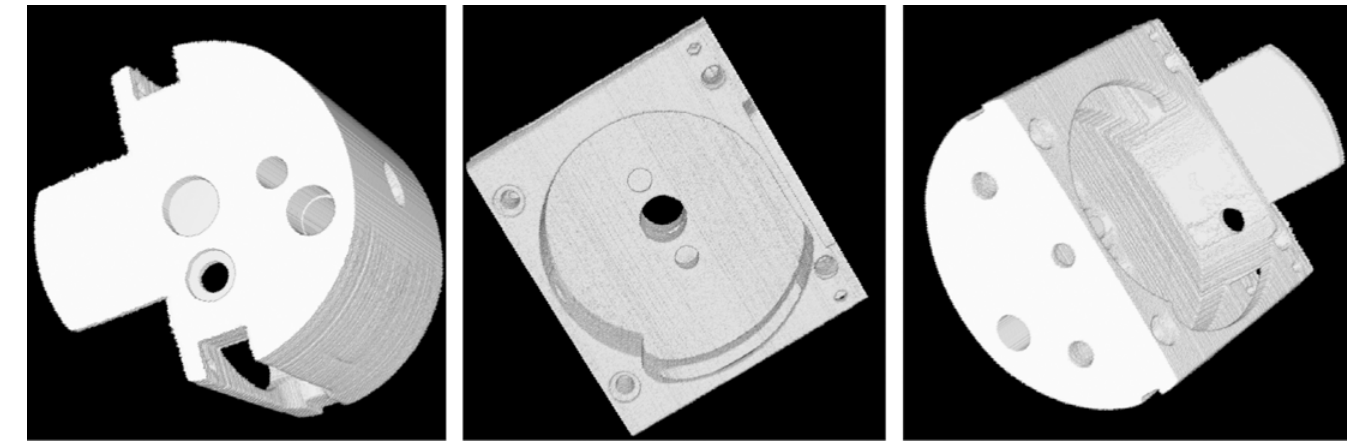
Fig 11. 3D visualizations of the real workpiece at various viewing